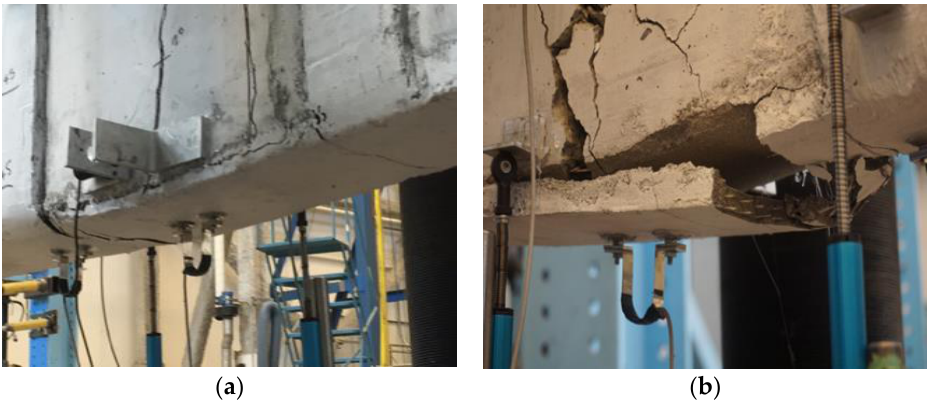
Figure 14. Glass FRCM-strengthened beam failure mode. ( a ): Premature bond failure of glass FRCM ; ( b ): Rupture of glass FRCM.